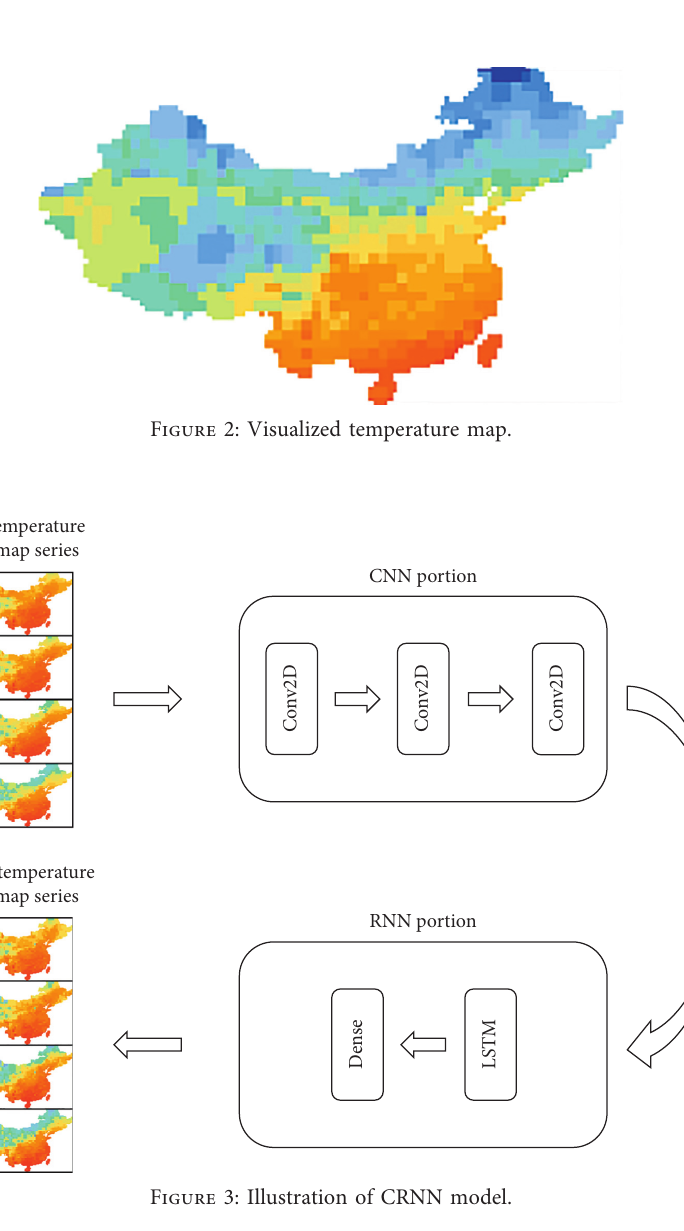
Figure 1: Temperature (in Celsius) and the corresponding color label.